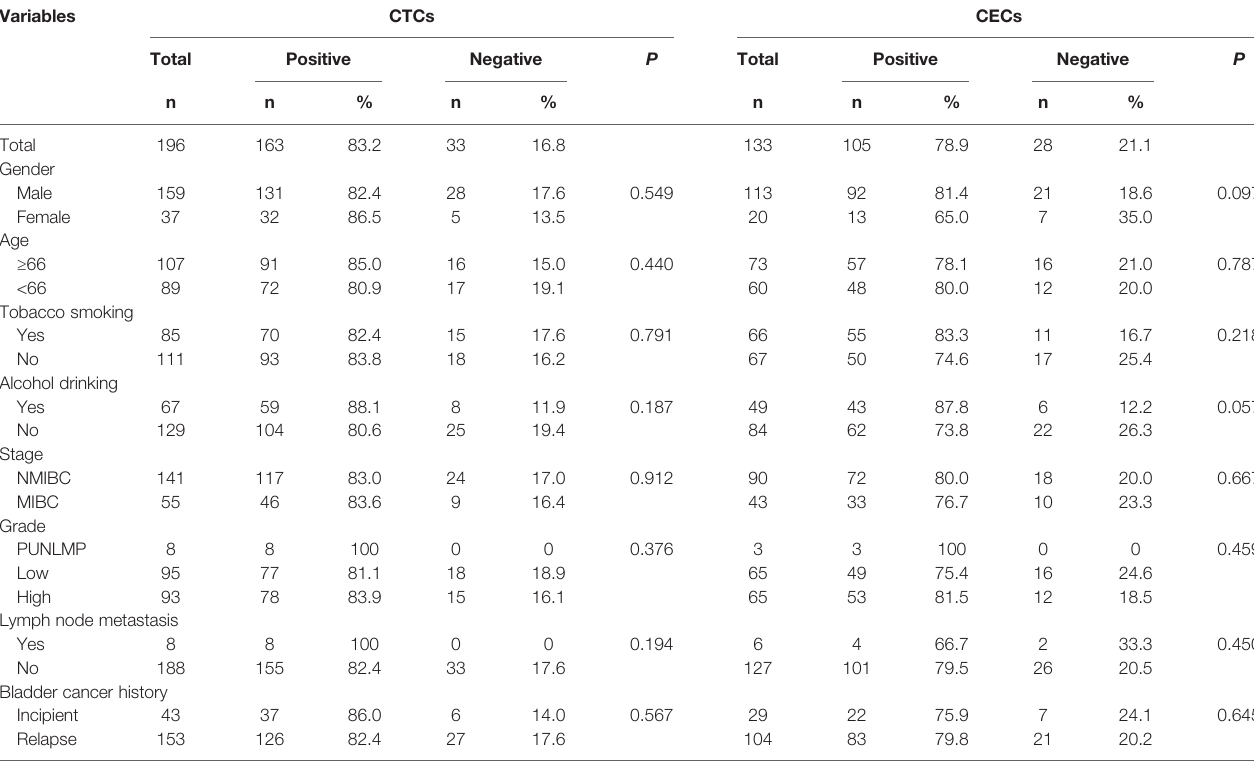
TABLE 1 | Relationship between CTC/CEC positive rate and clinicopathological variables.